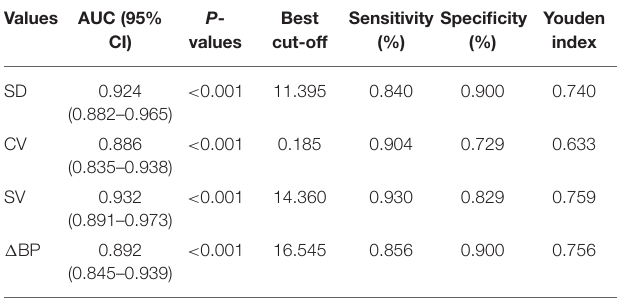
TABLE 5 | Cut-off values of PP variability. Values AUC (95%